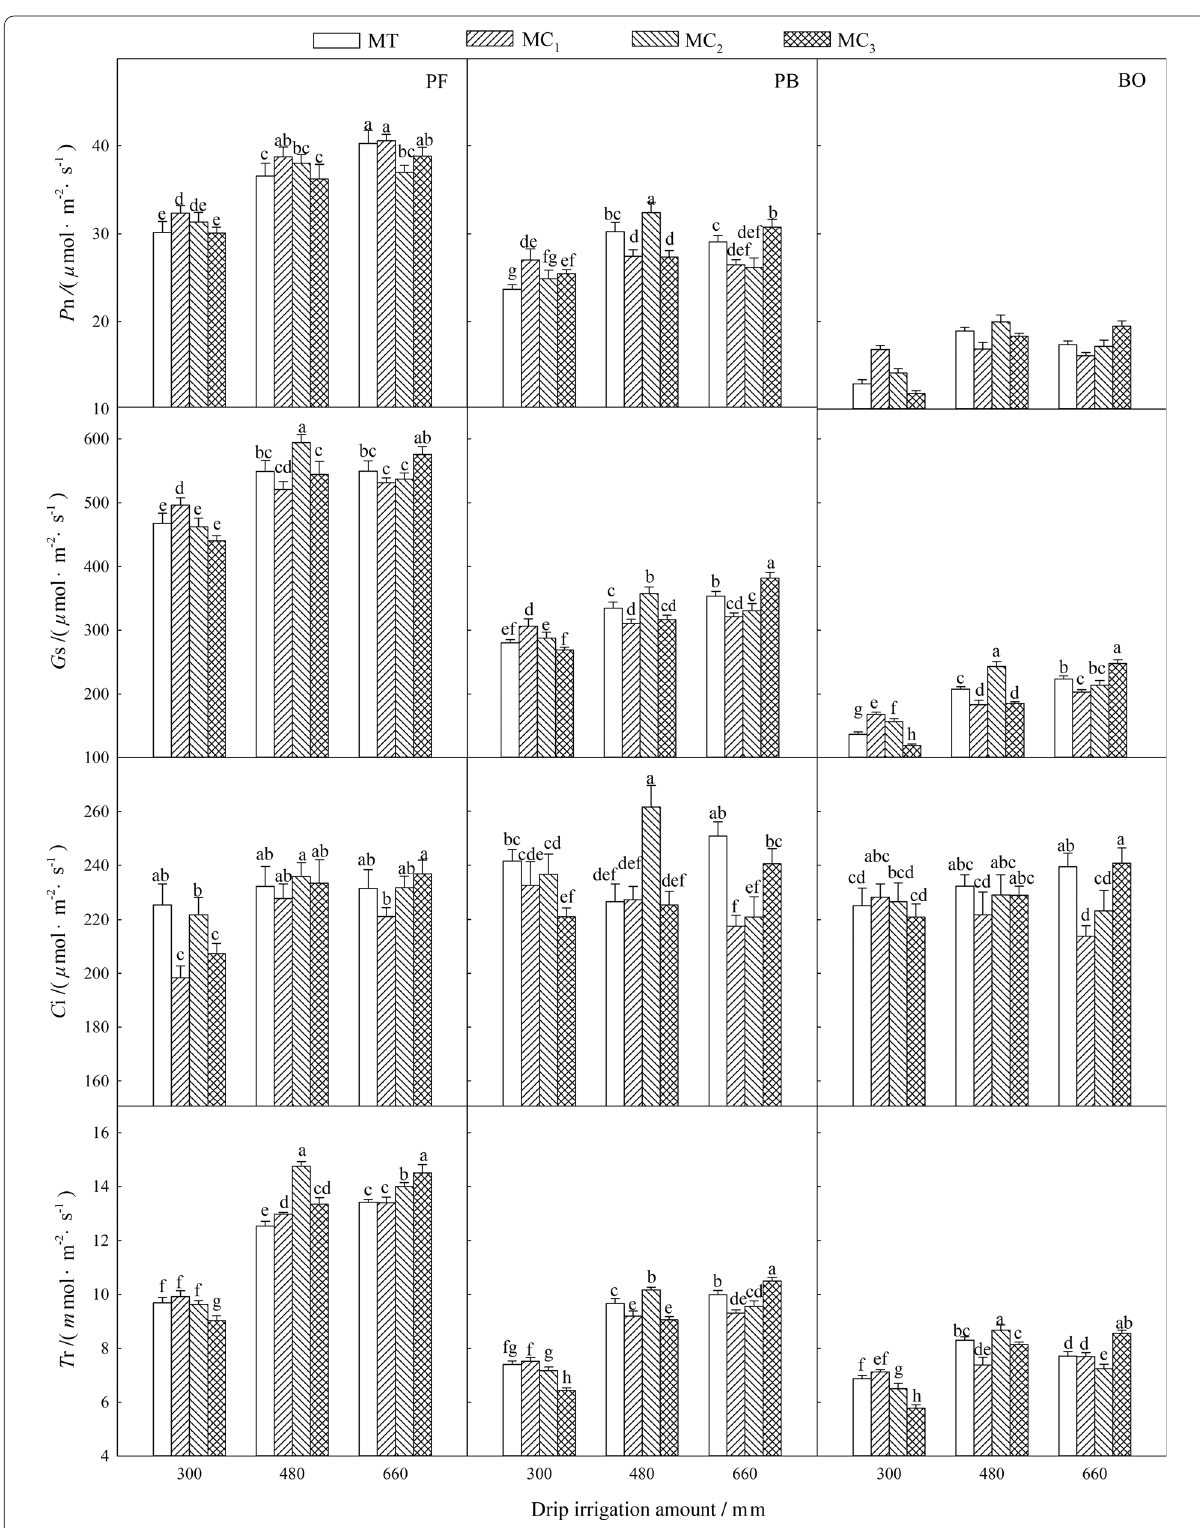
Fig. 1 (See legend on previous